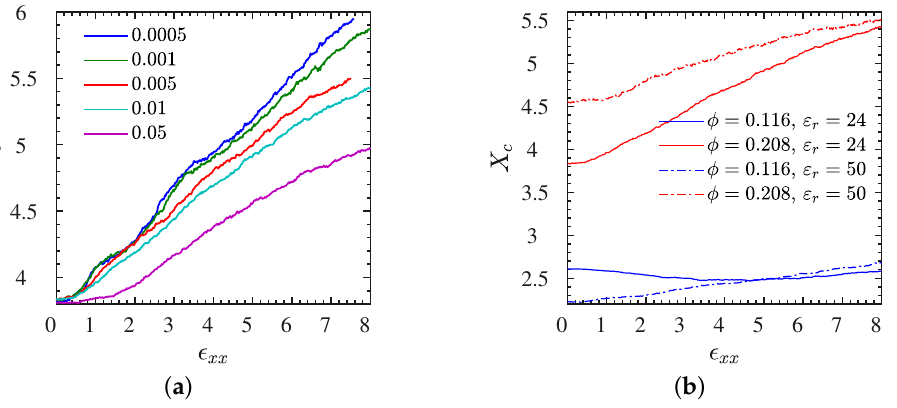
Figure 9. Crosslink data for all L systems. ( a ) Polymer–NP temporary crosslinks per chain X c as a function of elongational strain (cid:101) xx for systems with dielectric constant and NP loading of ε r = 24 and φ = 20.8% respectively, measured at different strain rates. ( b ) X c measured at various φ and ε r for samples subjected to a strain rate of ˙ (cid:101) xx = 0.01. All data shown here correspond to entangled systems with N = 200 chain length. Data for the short chain S systems available in Figure